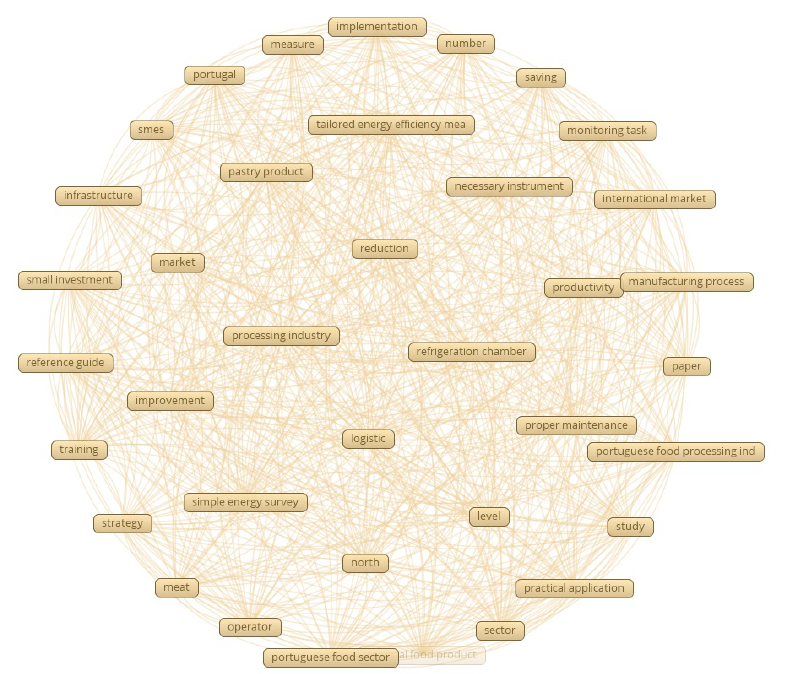
Figure 1. Visual map of the literature review on energy efficiency